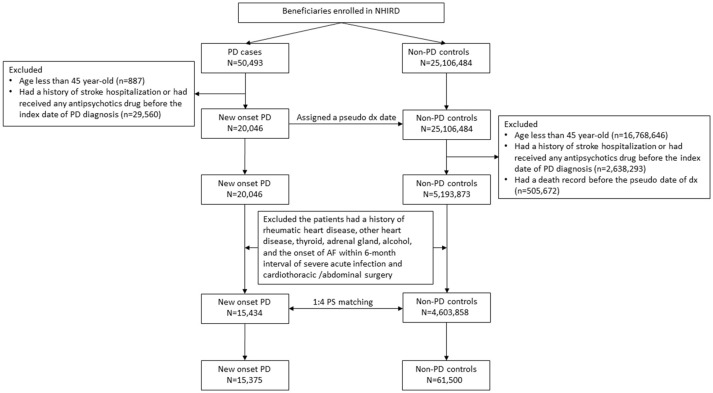
Flowchart of patient selection flowchart. PD, Parkinson's disease and AF, atrial fibrillation. Propensity score, PS.